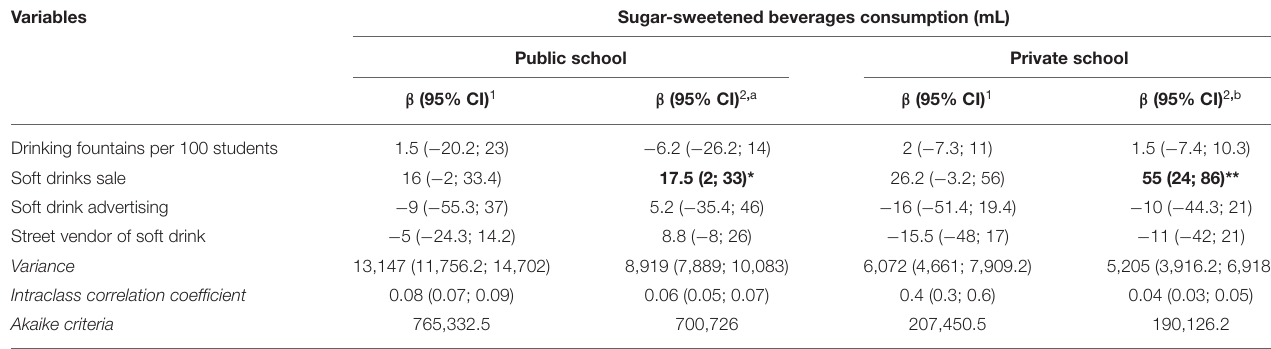
TABLE 3 | Association between sugar-sweetened beverages consumption and the school environment among Brazilian adolescents included in the ERICA study, Brazil (2013–2014; n = 71,549).